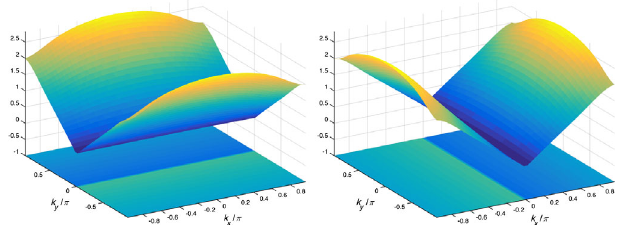
FIG. 7. Coarse-grained Hamiltonians for the wavelet-scaling and scaling-wavelet branches. We show the positive-energy branch (surface) and the relative phase difference between the two components of the positive-energy eigenmodes (color coding of the coordinate plane). Because the eigenmodes are indepen- dent of one of the two directions and take the form of the one- dimensional problem studied in Sec. III, the ground state can be disentangled by a tensor product of one-dimensional MERAs as in Fig. 1.